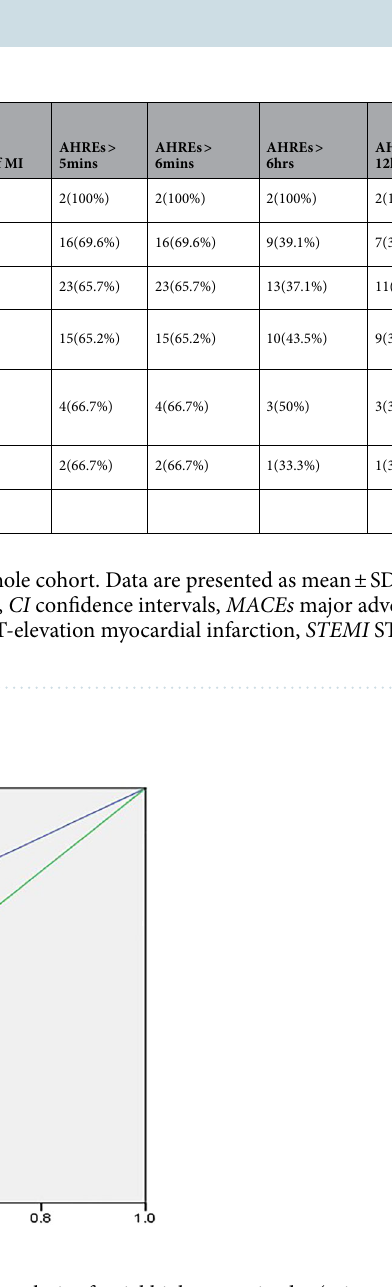
Figure 1. Receiver-operating characteristic curve analysis of atrial high-rate episodes (minutes) in patients with dual chamber permanent pacemakers with subsequent MACE Atrial high rate episodes (minutes): cutoff value, 5-min; sensitivity, 68.3%; specificity, 65.3%; AUC, 0.662; 95% CI, 0.588–0.736; p <